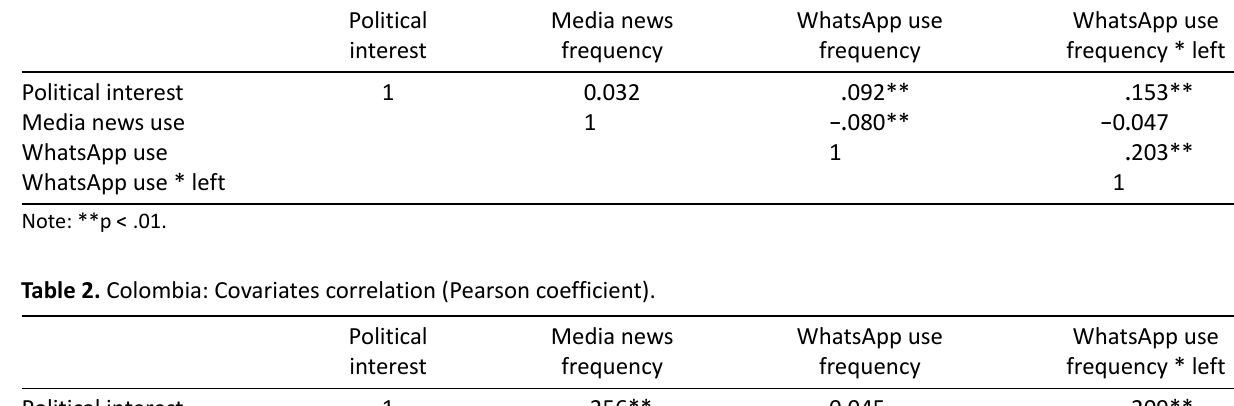
Table 1. Chile: Covariates correlation (Pearson coefficient).